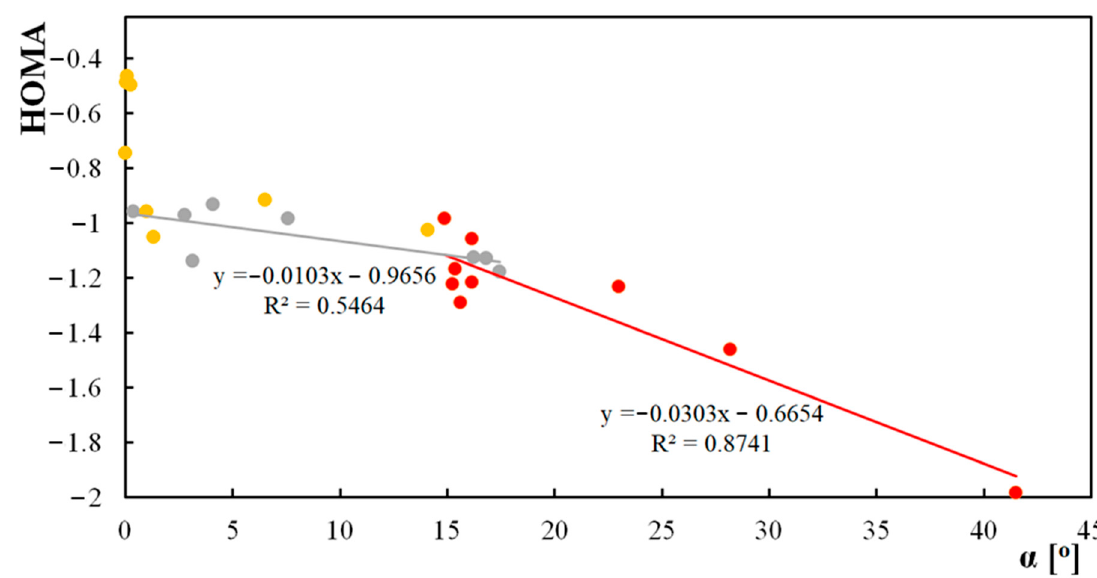
Figure 5. Correlations between HOMA parameters for the central ring and α angle: yellow-anthraquinones with a substituent NH 2 and NO 2 , red-anthrones with a substituent in the central ring, and grey-anthrones with a substituent NH 2 and NO 2 in the side ring.